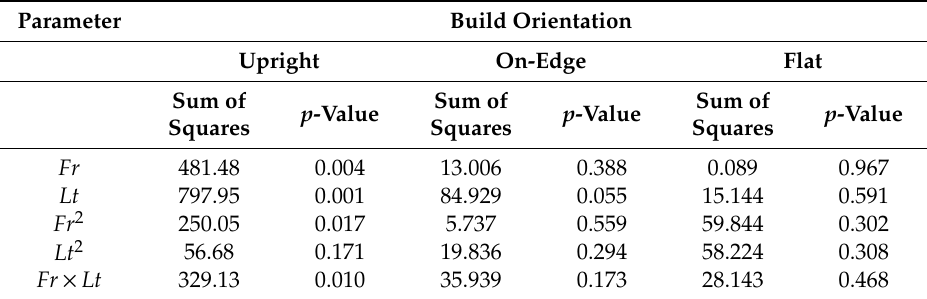
Table 3. ANOVA analysis of